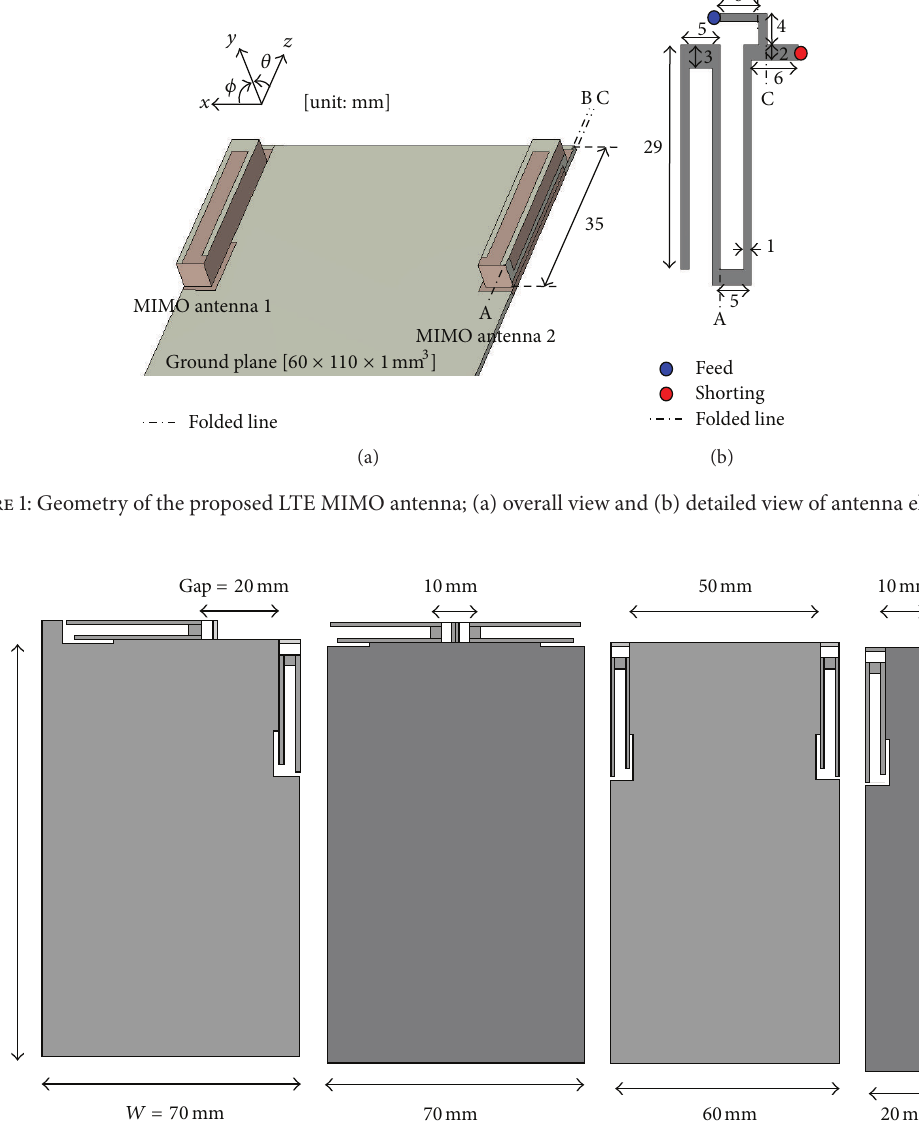
symmetrically arranged on the top sides of the ground